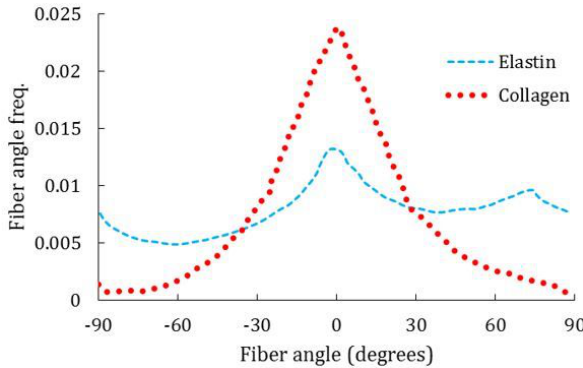
Figure 1: Distribution of collagen and elastin in LU; Angle of 0o means circumferential direction and 90o is along the length of artery [20]